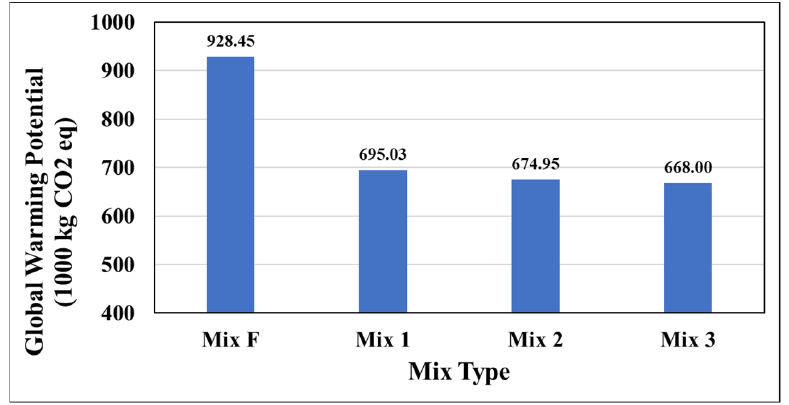
Figure 8. Global Warming Potential (GWP) by mix type.